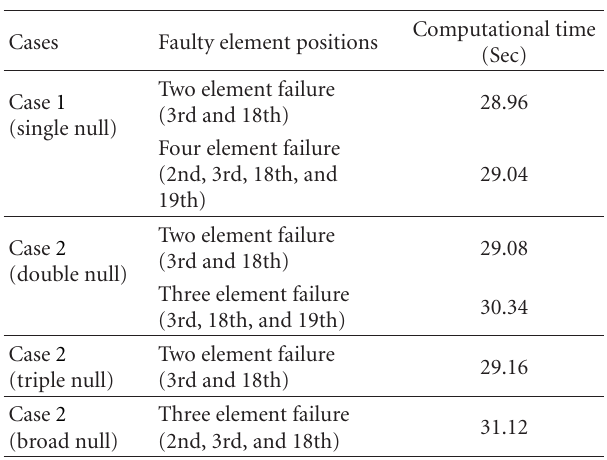
Table 9: Computational time for the configurations discussed in Cases